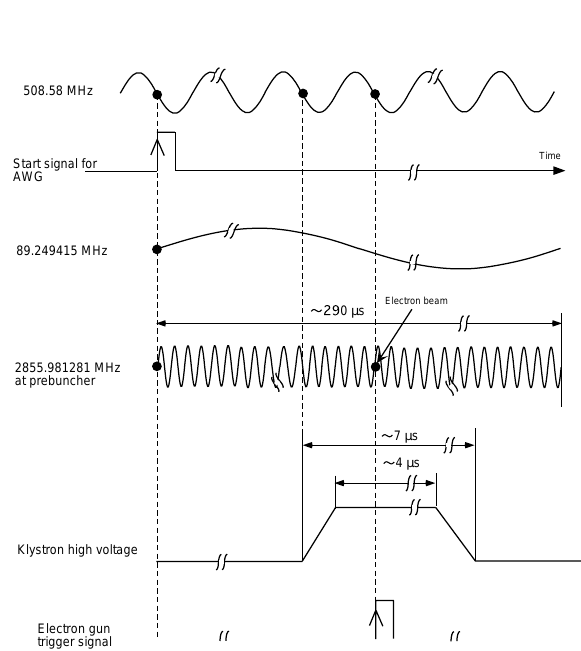
FIG. 4. Schematic timing charts for all signals, that is, a 508.58 MHz rf, start signal for an AWG, generated 2856 MHz rf, supplied high voltage for klystrons, and electron gun trigger signal. In particular, the start signal for the AWG, high voltage supplied to the klystrons, and the gun trigger signal are syn- chronized with the 508.58 MHz rf. Start time of the 2856 MHz rf is guaranteed by synchronization with the 508.58 MHz rf. Phase differences in any time points between the two rf’s are kept constant for approximately 290 m